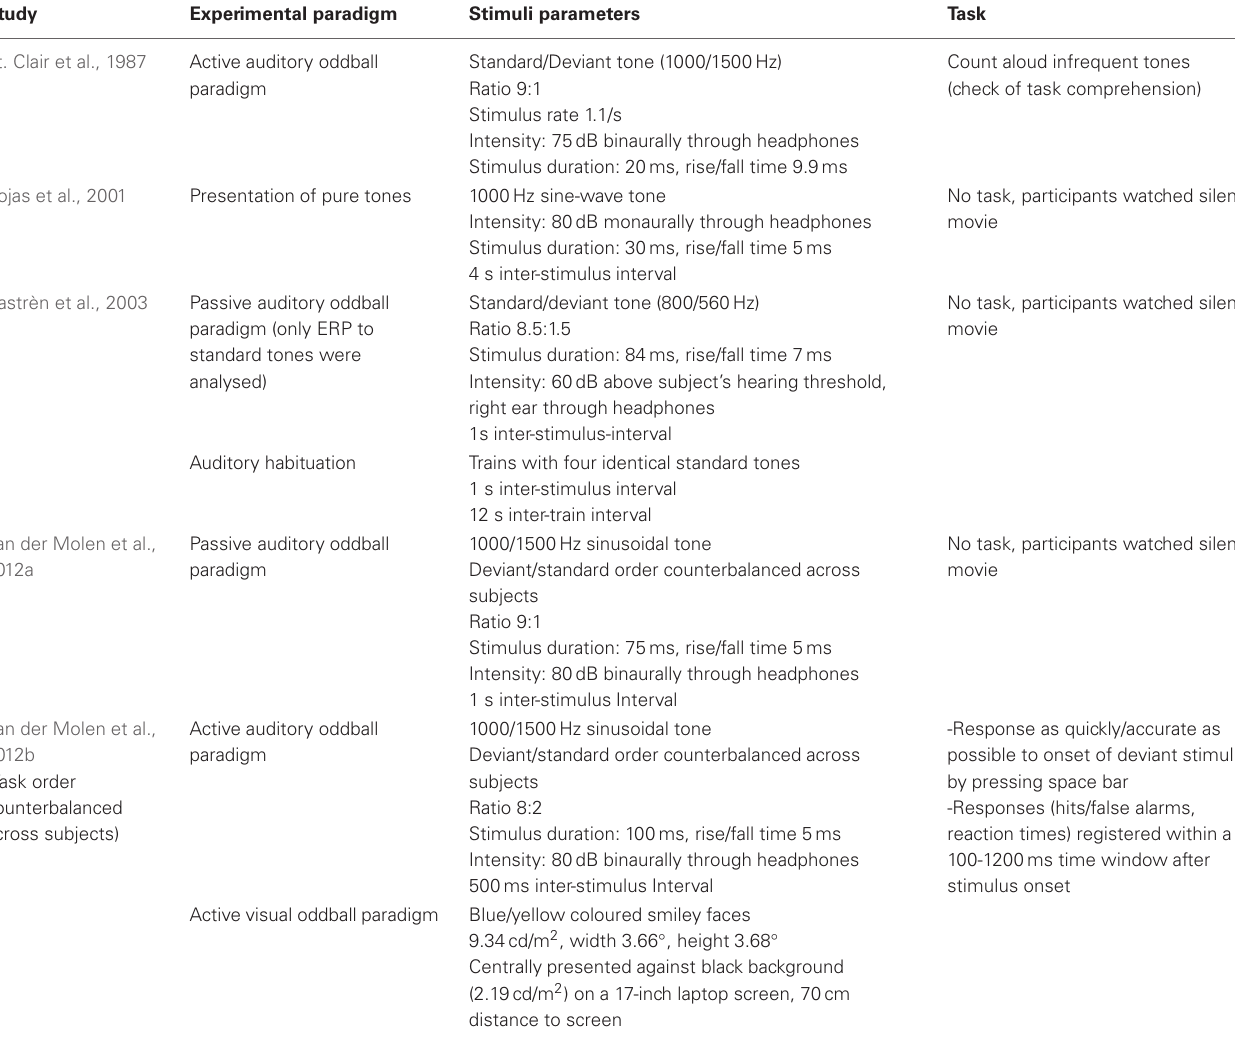
Table 3 | Comparison of the experimental procedures used in the reviewed studies.